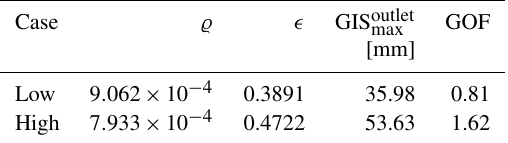
Table 4. Greenland SID sea level component calibration results with optimal parameter sets for the low and high cases introduced by Nick et al. (2013). Calibration parameters are introduced in Sect. 2.6. GOF is given as weighted RSS divided by the number of calibrated model years (weight Greenland SID SLE contribution [mm]: 1).